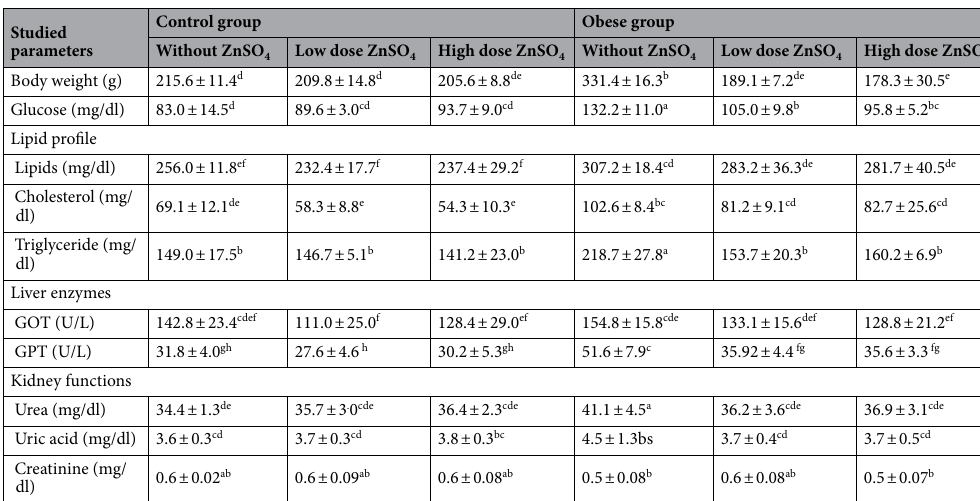
Table 4. Body weight, serum glucose level, lipid profile, liver and kidney functions in control and obese groups without ZnSO 4 tretatment, low dose (15 mg) ZnSO 4 treatment, and high dose (30 mg) ZnSO 4 treatment in female rats. Data was expressed using Mean ± SD. Means in the same raw with small common letters are not significant (i.e. means with different letters are significant). SD standard deviation.